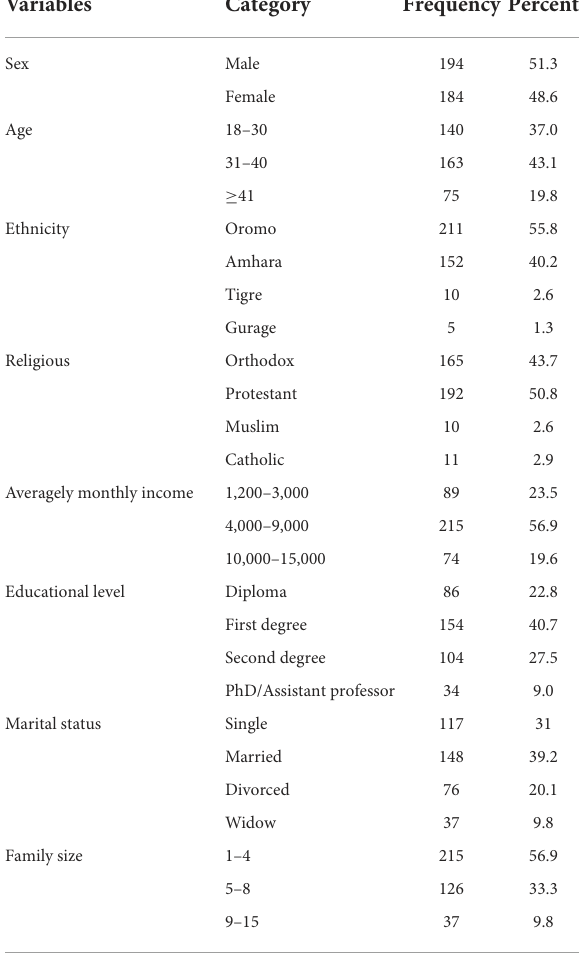
TABLE 1 Socio-demographic characteristics of the Ambo University community participating in the study, Ethiopia, 2022.